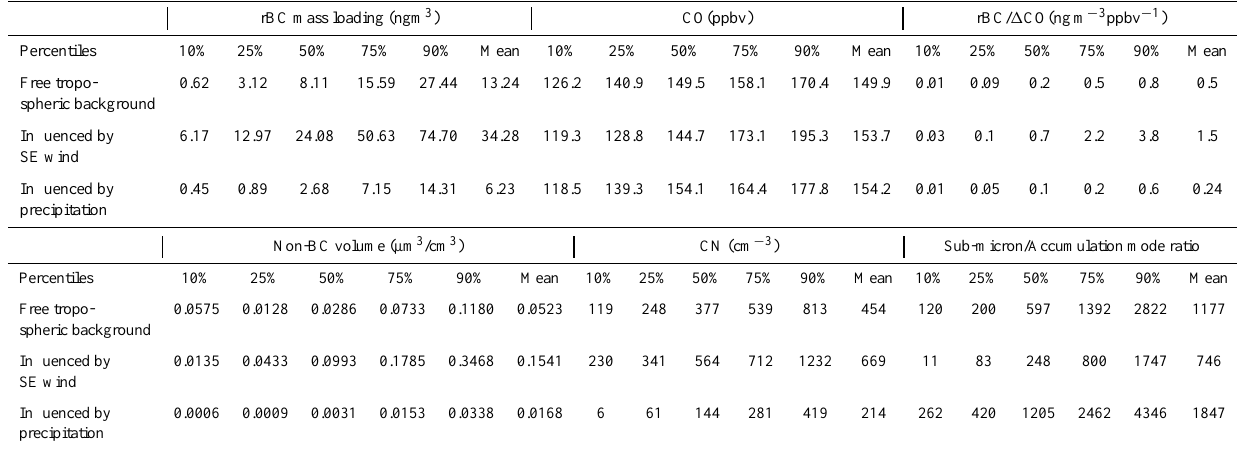
Table 3. A summary of the data presented in Fig. 7, including the median value, mean value and 10%, 25%, 75%, 90% percentiles for each